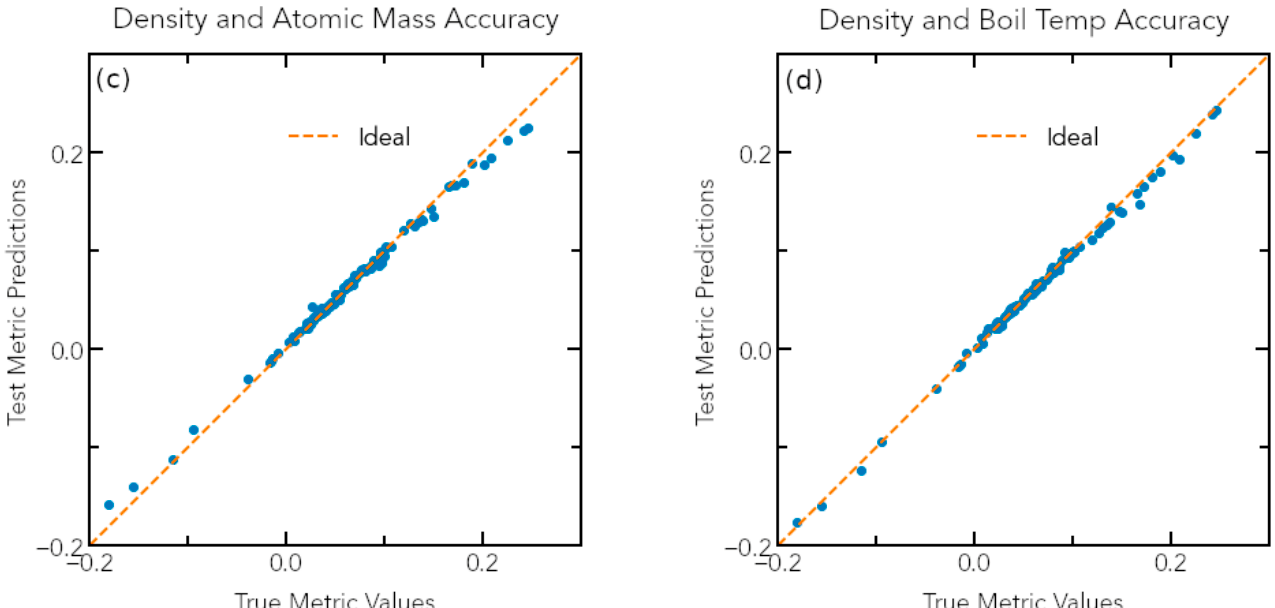
Figure 3. By restricting the input predictors, we were able to determine the atomic parameters that, combined with composition, are necessary for the CNN to effectively predict the metric defined in Equation (7). ( a ) Density only; ( b ) Atomic mass only; ( c ) Density and Atomic Mass; ( d ) Density and Boiling Point. The minimal set to produce predictions as good as the full model requires two parameters, e.g., density and boiling point. The ideal line is a line of slope one and intercept zero—the closer to this line, the closer the CNN is properly predicting metric values.